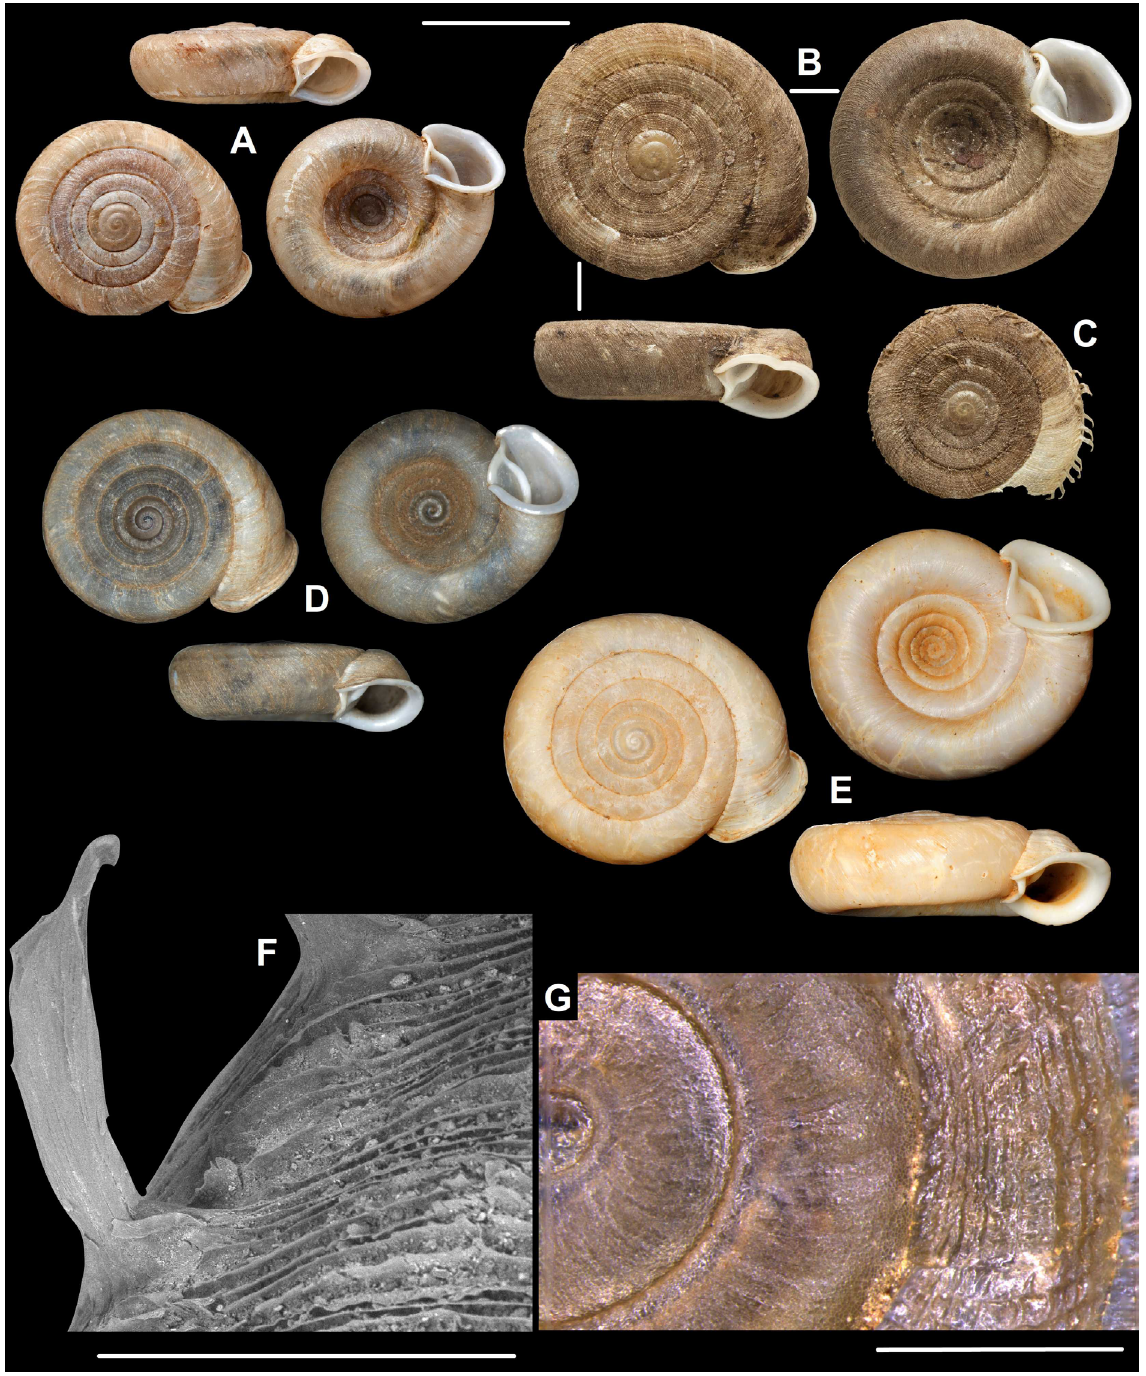
Fig. 9. Shells of Chersaecia dextrorsa (Benson, 1860). A . Holotype (NHMUK 1906.2.2.144). B–C . Adult and juvenile syntypes of Helix ( Plectopylis ) brachydiscus Godwin-Austen, 1879 syn. nov. (NHMUK 1903.7.1.752). D . Shell from Thailand (UF 76507). E . Shell from Thailand (UF 346181). F . Deciduous periostracal fold (UF 76385). G . Protoconch (same specimen as D). Scale bars: A–E = 10 mm; F–G = 1 mm. Images: H. Taylor (A–C), T. Deli (D–E) and B. Páll-Gergely